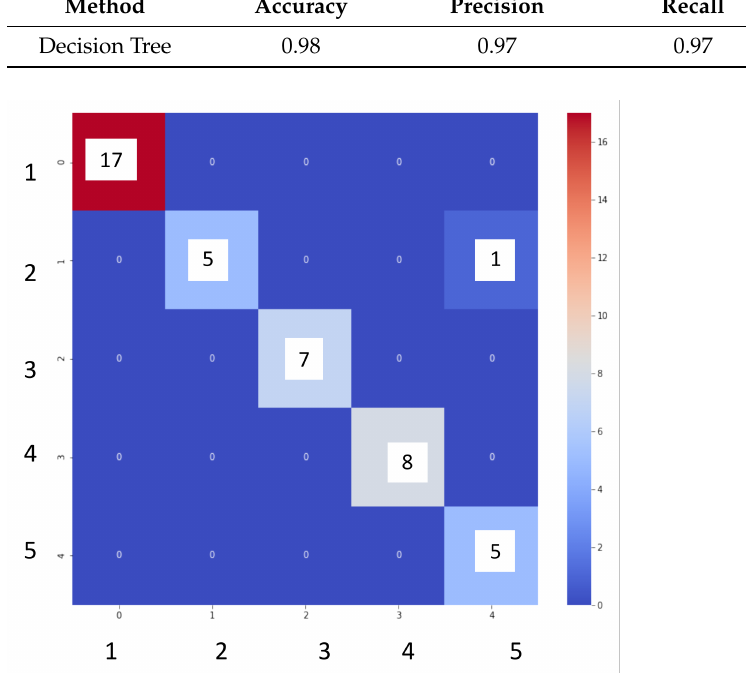
Figure 7. Confusion matrix for the decision tree method—flow and pressure